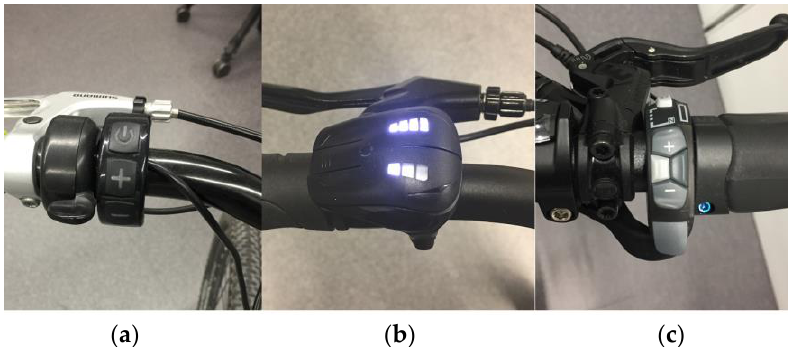
Figure 3. Example of three assist level commercial controllers: ( a ) Bafang controller; ( b ) ebikemotion controller; and ( c ) BionX controller.